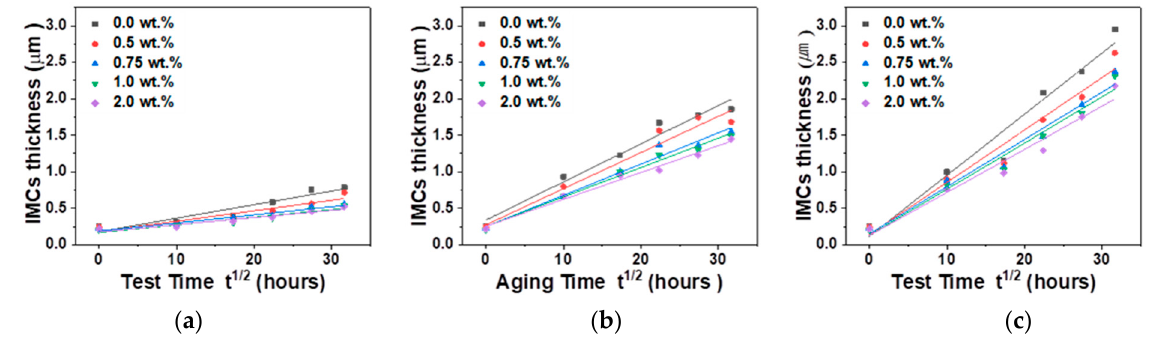
Figure 5. Total intermetallic compounds (IMCs) thickness as a function of test time at temperatures: ( a ) 85 °C ( b ) 100 °C, and ( c ) 115 °C .